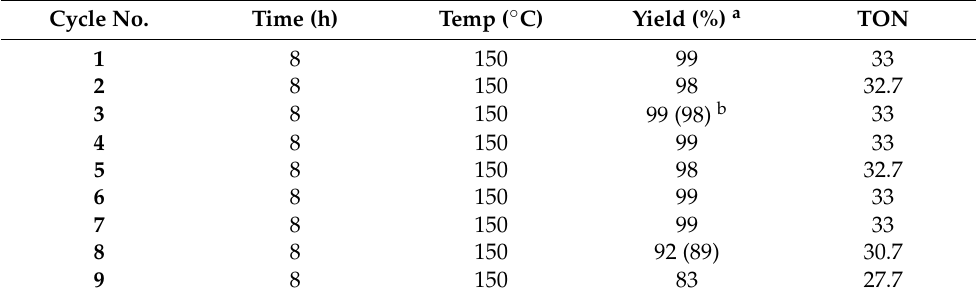
Table 11. Recycling results of 2c -catalyzed Suzuki-Miyaura reaction of aryl boronic acid ( 11 ) with 4-cyanobromobenzene ( 16 ) under the thermomorphic mode. Cycle No.